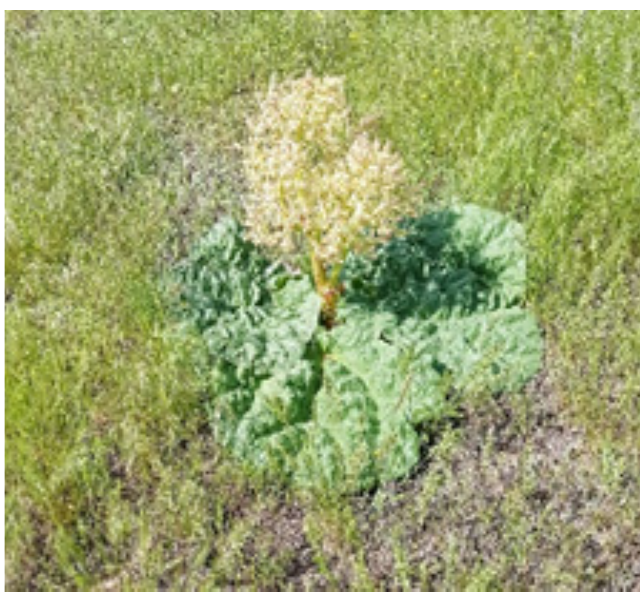
Figure 1. Rheum tataricum of Bogdinsko-Baskunchak Nature Reserve. Inhabiting semi-desert and desert areas, R. tataricum is highly tolerant to salinity, drought, and nutrient deficiency, which may become the basis for intensive selection aimed to improve plant quality and increase adaptability to environmental stress. Lack of this plant slows our knowledge of rhubarb adaptability and utilization possibilities.